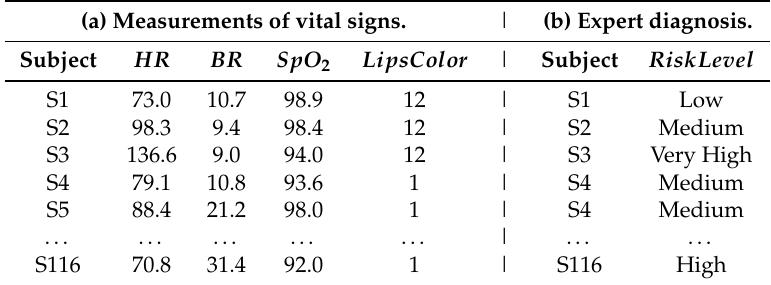
Table 4. Some samples from the created dataset.